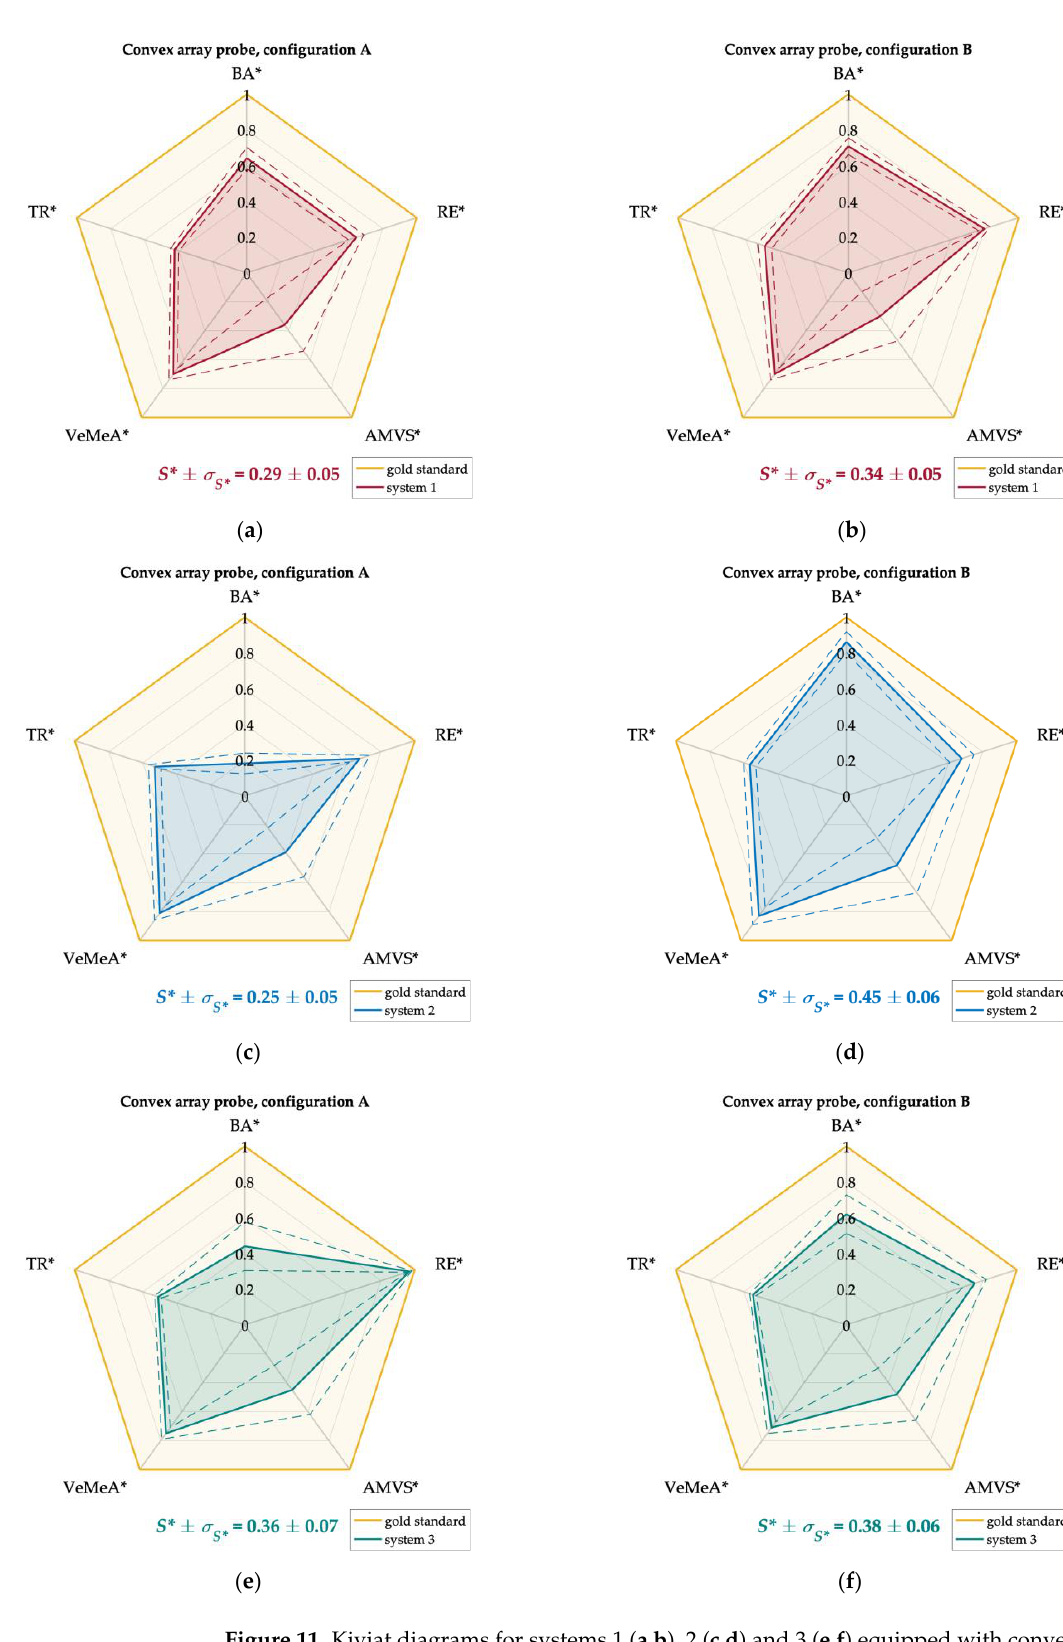
Figure 10. Kiviat diagrams for systems 1 ( a , b ), 2 ( c , d ) and 3 ( e , f ) equipped with phased array probes in configurations A ( a , c , e ) and B ( b , d , f ), for high flow rate regime Q H . Each polygon area was nor- malized with respect to the gold standard one.